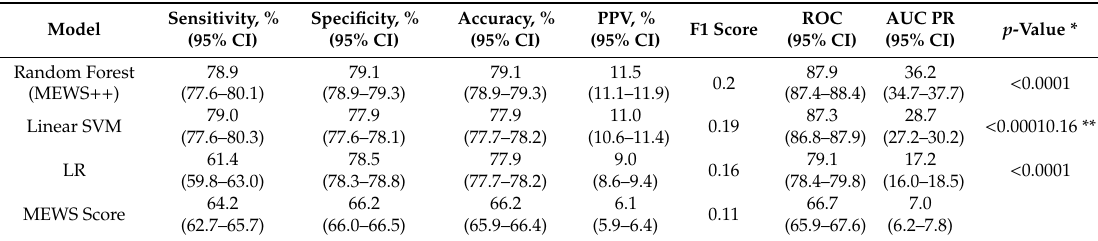
Table 2. Model performance metrics.